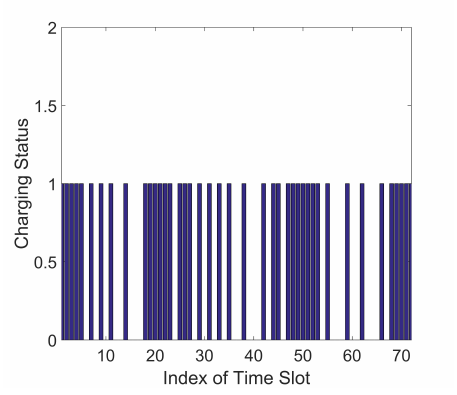
Figure 9. Charge status in 72 time slots. For each slot, it presents one hour. The value of “1" means a charging status.